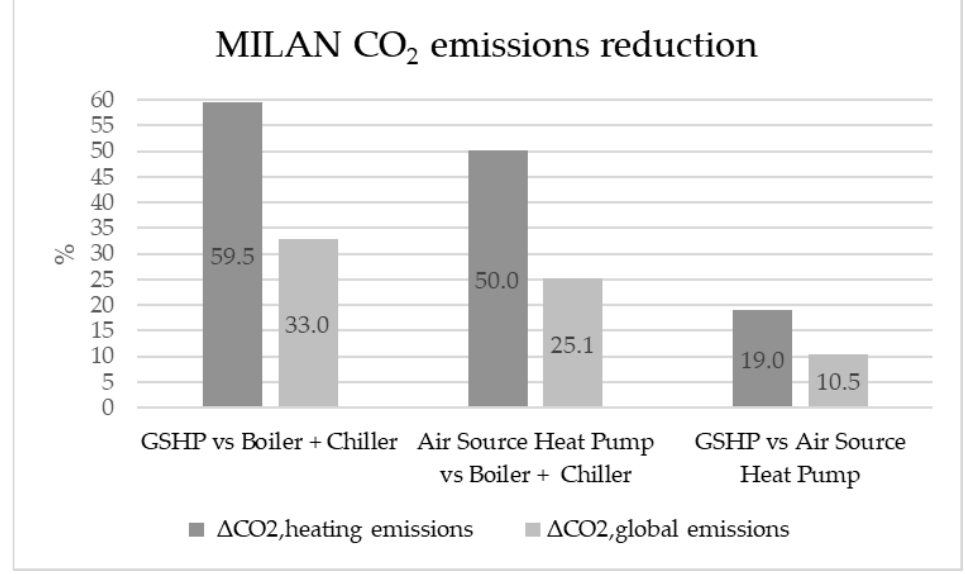
ff erent solutions in